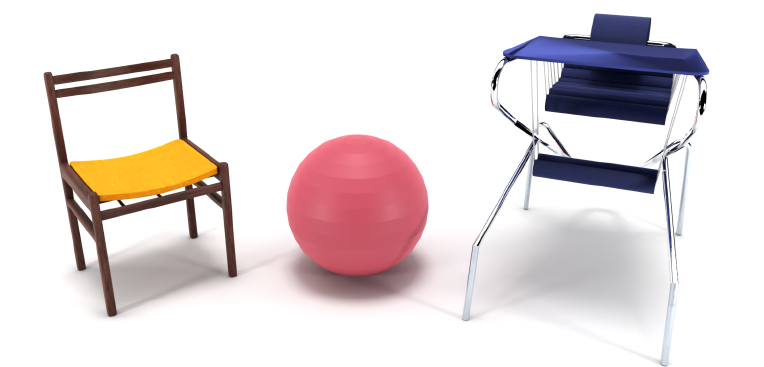
Figure 1. From left to right: school chair, therapy ball, active